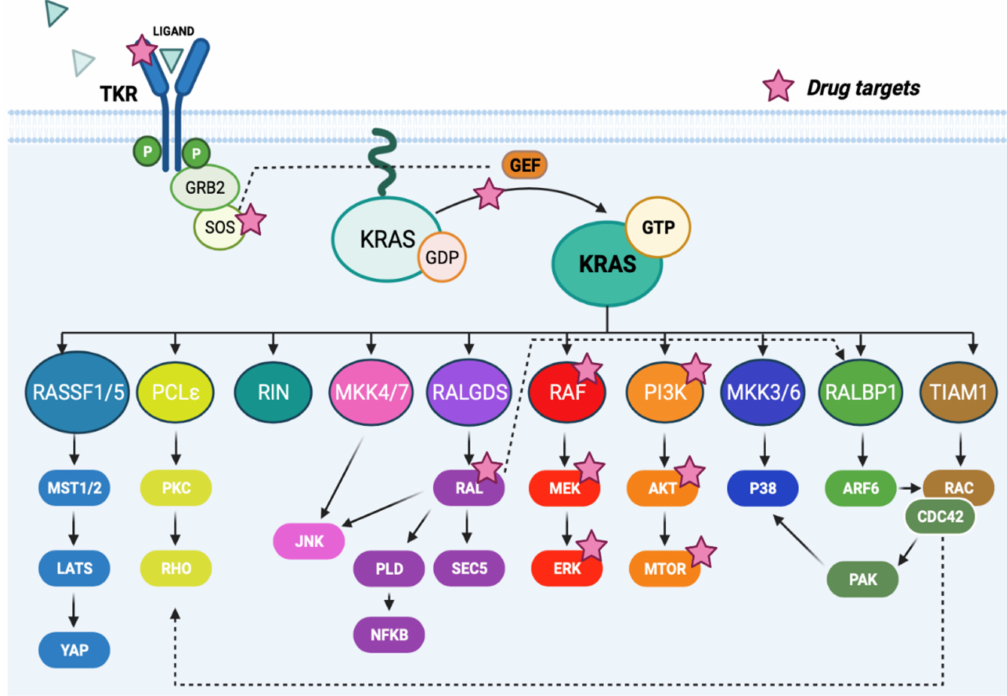
Figure 1. KRAS downstream effector pathways. The active form of KRAS (KRAS-GTP) regulates many signaling pathways affecting essential cellular functions such as cell proliferation,